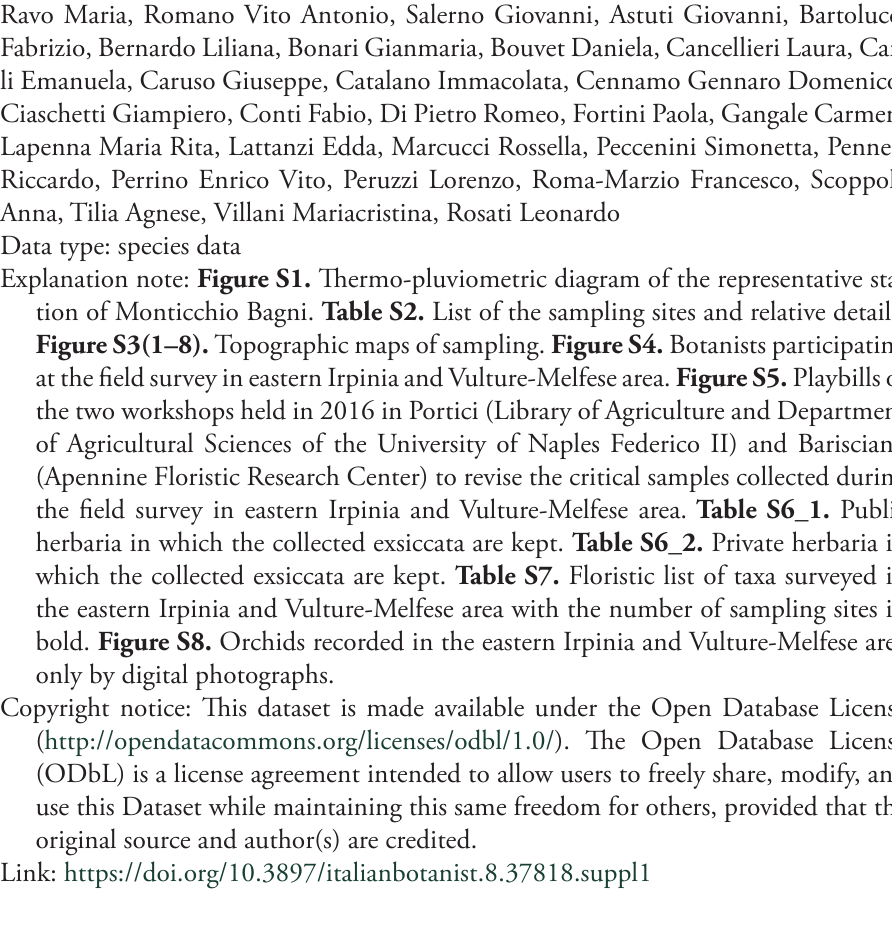
bold. Figure S8. Orchids recorded in the eastern Irpinia and Vulture-Melfese